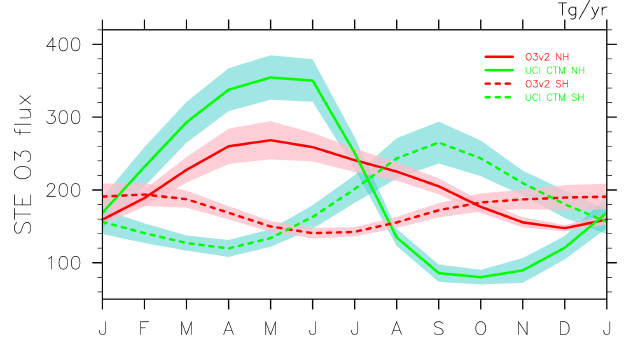
Figure 6. Mean annual cycle of the stratosphere troposphere ex- change (STE) ozone fluxes (unit: TgO 3 per year) in the NH (solid lines) and SH (dashed lines) for O3v2 (red) and UCI CTM (green). The lines indicate the climatology mean, and the shaded area covers the mean ±